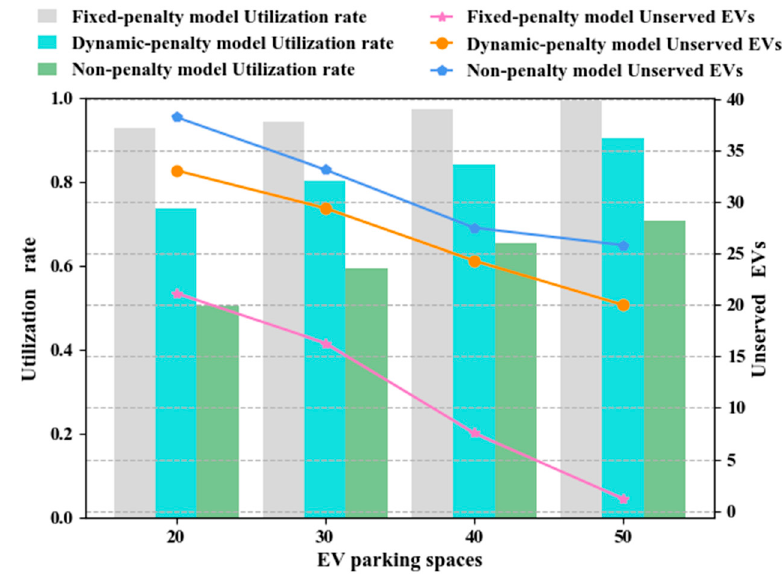
Figure 14. The impact of increasing EV parking spaces on unused EVs and utilization.